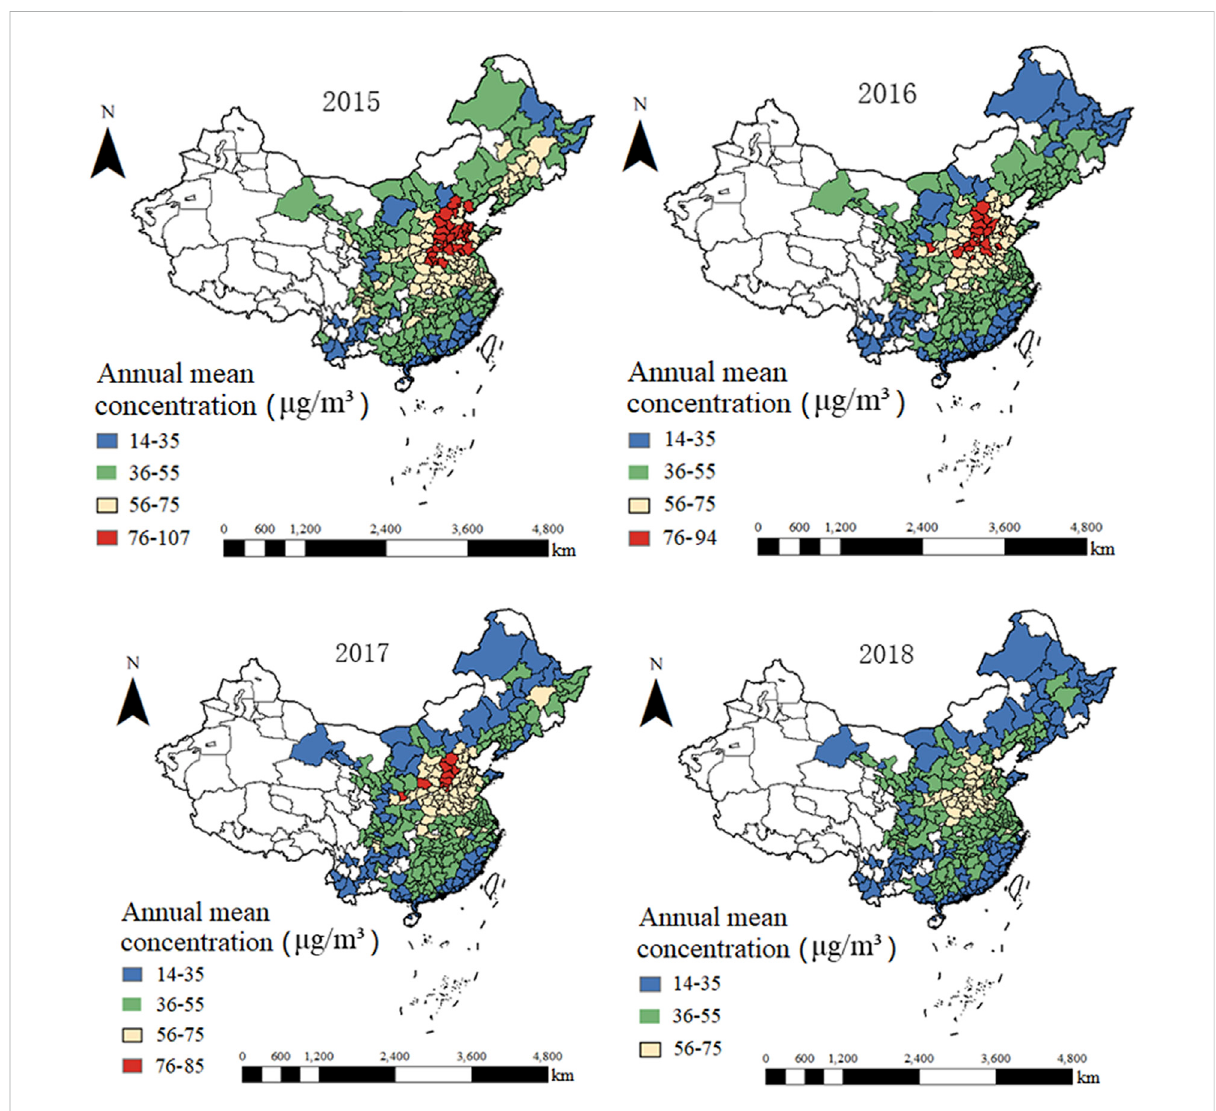
FIGURE 1 Spatiotemporal variation characteristics of the annual mean PM 2.5 concentrations in China from 2015 to 2018.